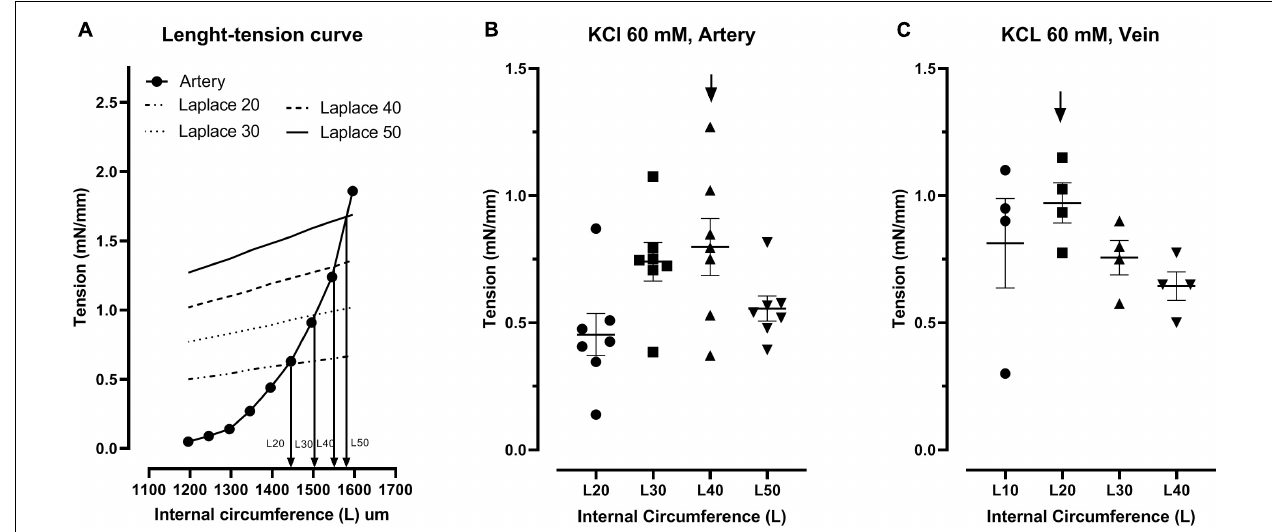
FIGURE 2 | Determination of optimal internal circumference. Umbilical artery length-tension curve and theoretical straight line of Laplace (for a pressure of 20, 30, 40, and 50 mmHg) (A) . Tension developed in response to 60 mM KCl at different internal circumference in arteries n = 8 (B) and veins n = 4 (C) . Arrow indicated the optimal internal circumference for both vessels in subsequent